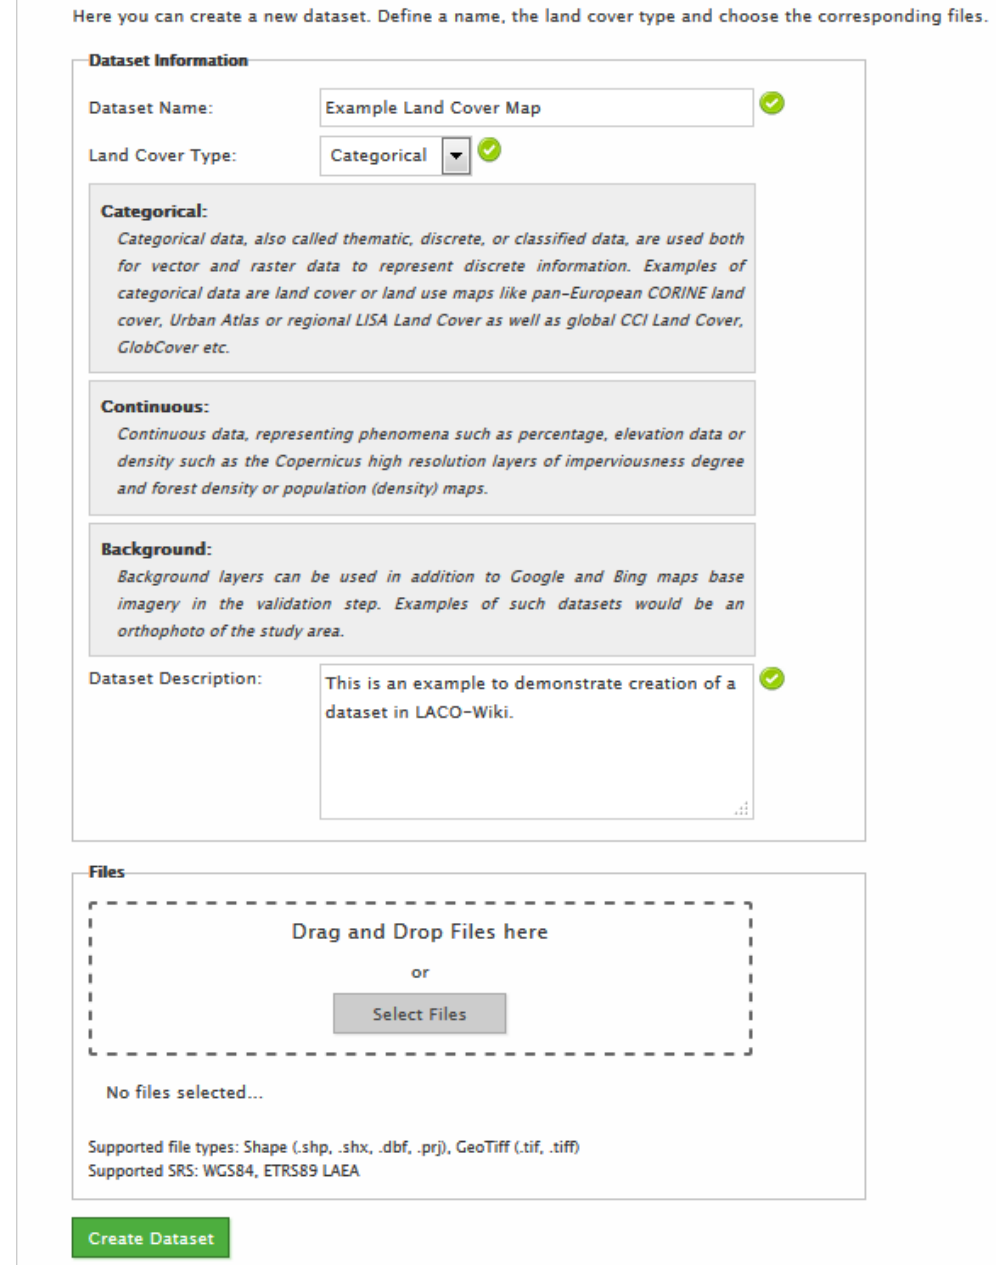
Figure 4. Uploading a land cover map in Step 1 of the LACO-Wiki validation workflow.